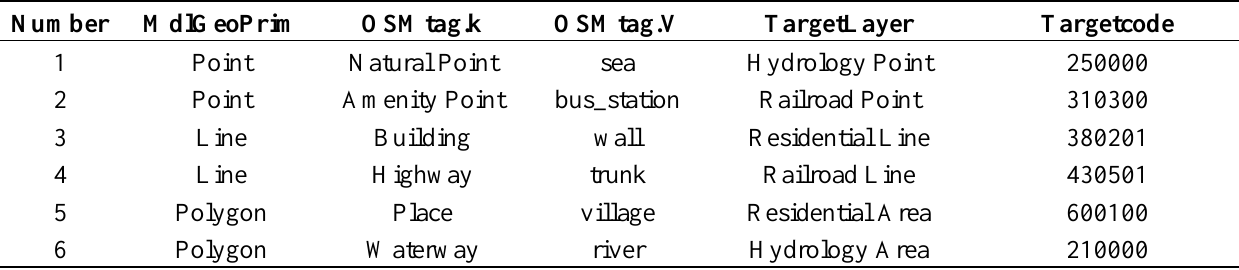
Table 1. Exemplary rules for converting the spatial objects in the middle model to the user destination